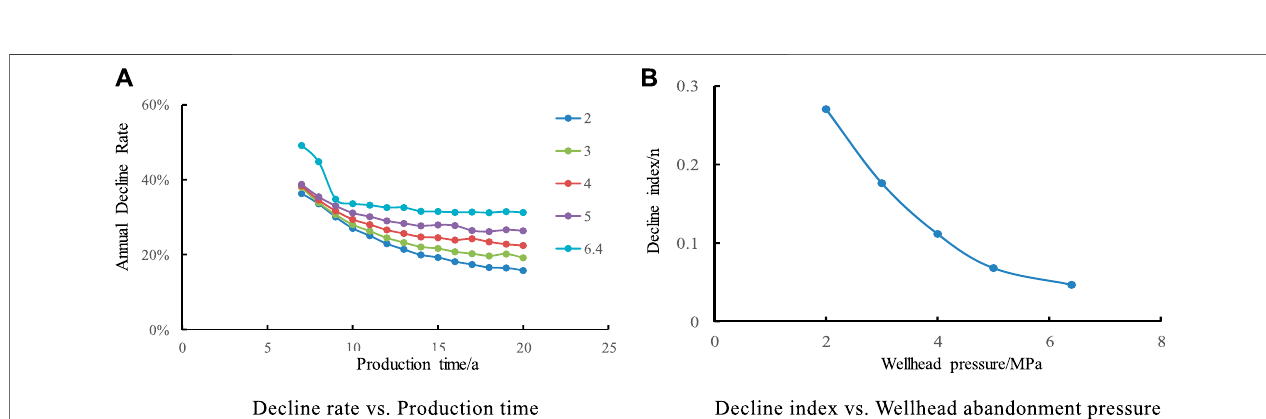
FIGURE 8 | Effect of wellhead abandonment pressure on Annual Decline Rate and decline index. (A) Decline rate vs. Production time. (B) Decline index vs. Wellhead abandonment pressure.